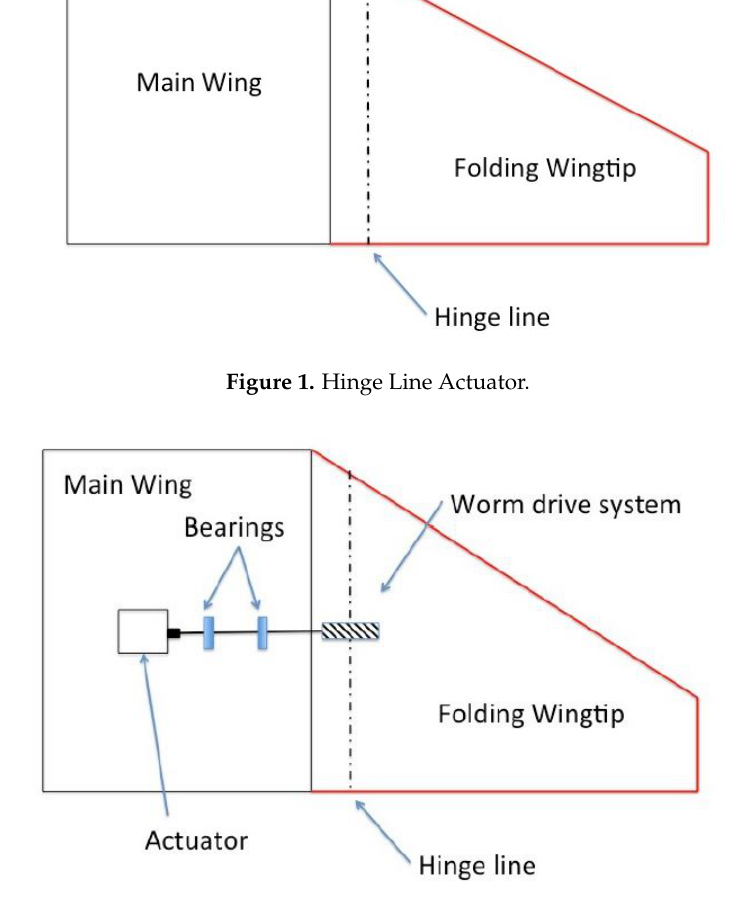
Figure 2. Worm Gear